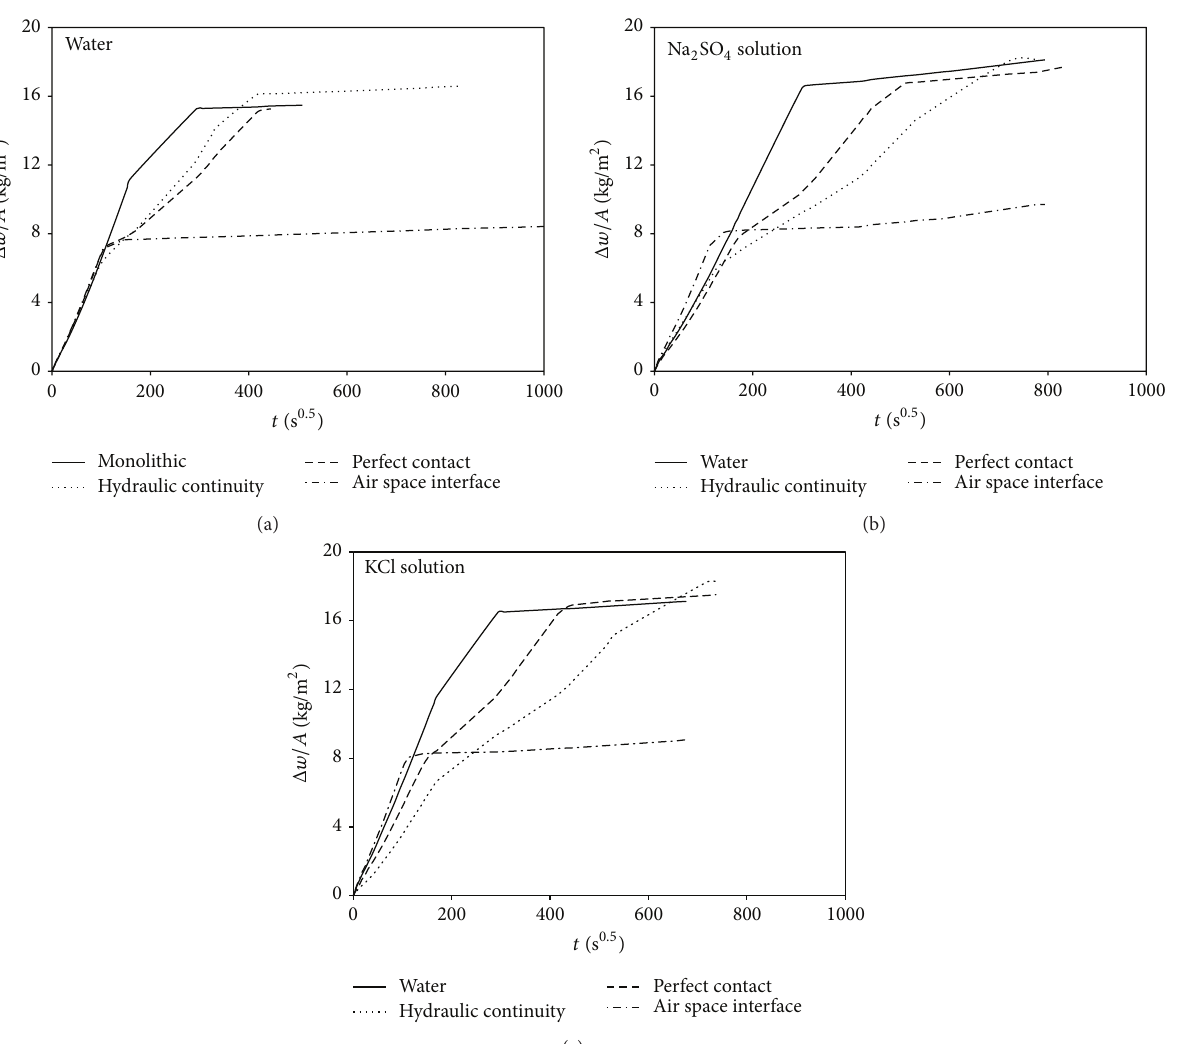
Figure 6: Representation of the absorption in the monolithic specimens and specimens with hydraulic continuity interface, perfect contact interface, and air space interface, for (a) pure water, (b) saturated solution of KCl, and (c) saturated solution of Na 2 SO 4 .